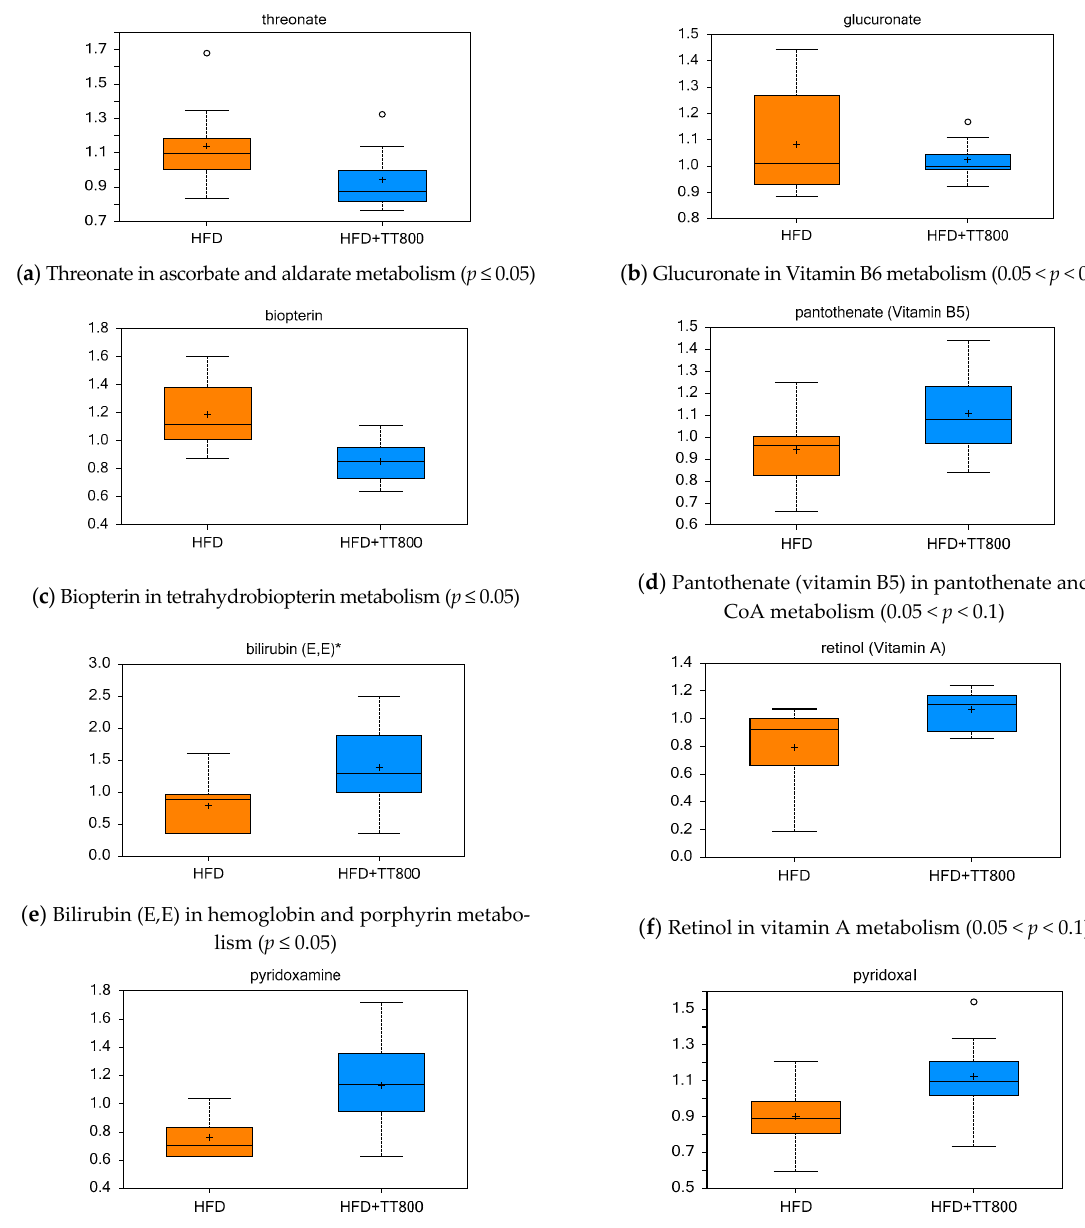
Figure 3. Effect of TT supplementation on serum cofactor and vitamin metabolites. TT may conserve pantothenate and CoA use for oxidative and biosynthetic reactions in intermediary metabolism, and intermediates of retinoic acid metabolism in mice, in contrast to a HFD that leads to anabolic responses for fat deposition. TT supplementation appears to reduce levels of biopterin for amino acid metabolism in support of neurotransmitter formation. Each dietary group was comprised of n = 10 mice.